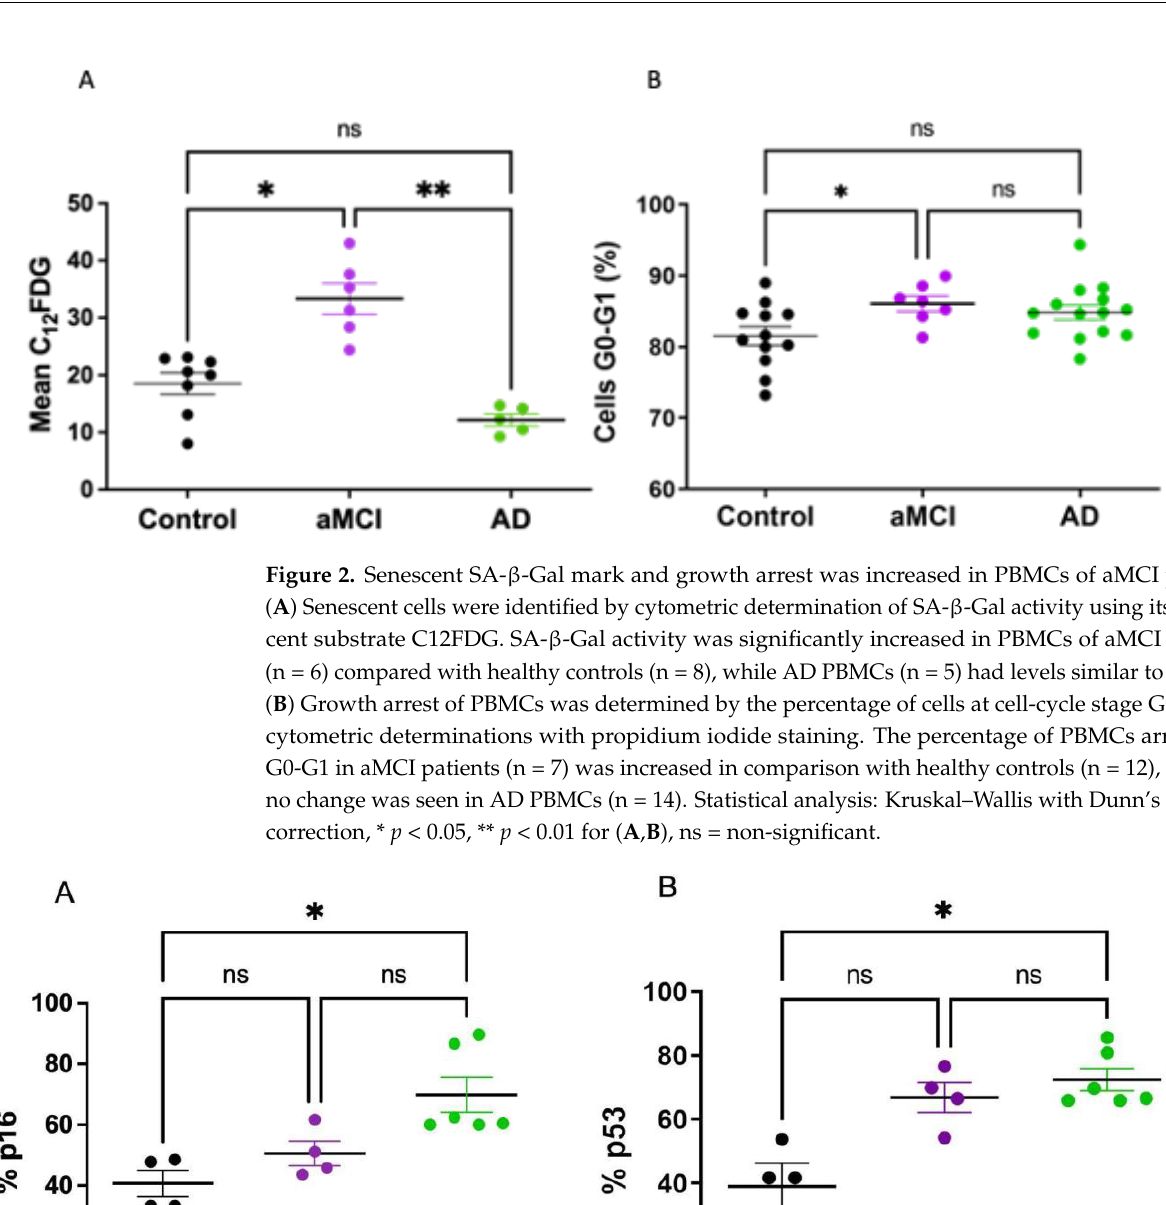
Figure 3. p16 and p53 expression was increased in PBMCs of AD patients. The expression of p16 ( A ) and p53 ( B ) was determined by flow cytometry in PBMCs from controls (n = 4), aMCI (n = 4) and AD (n = 6) patients. p16 and p53 expression was increased in AD patients compared with healthy controls, with no significant change in aMCI. Statistical analysis: Kruskal–Wallis with Dunn’s post hoc correction * p < 0.05, ns = non-significant.